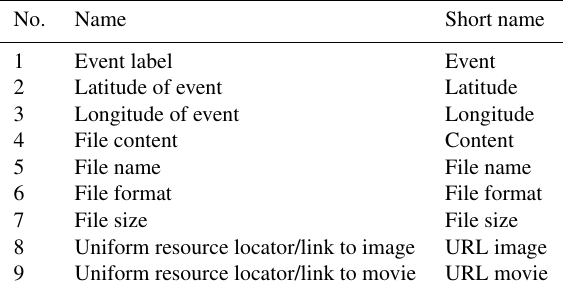
Table 12. Structure of the image and video collection of field sites at PANGEA (Lasser et al., 2020a). The data table contains links to the individual images and time lapse movies.